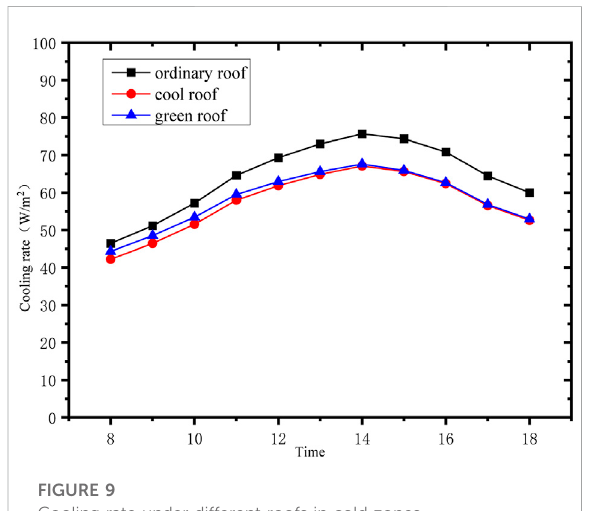
FIGURE 9 Cooling rate under different roofs in cold zones.